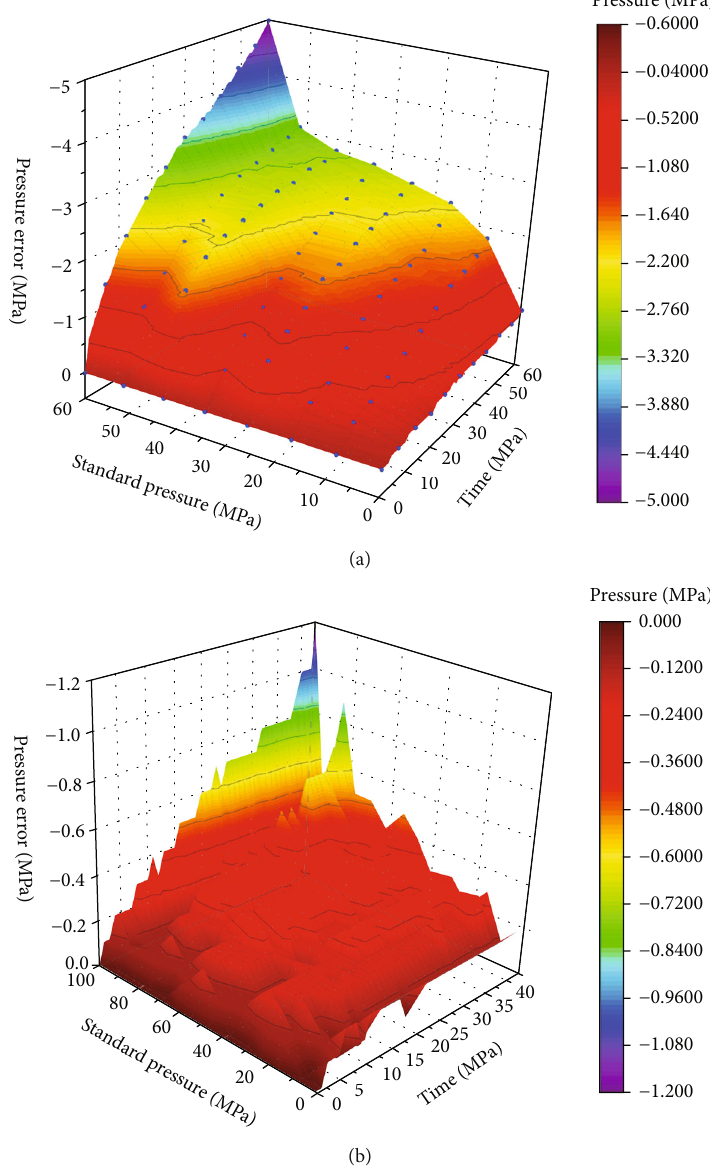
Figure 14: Test results for the pressure-maintaining controller. (a) Leakage rate of conical sealing. (b) Leakage rate of wedge